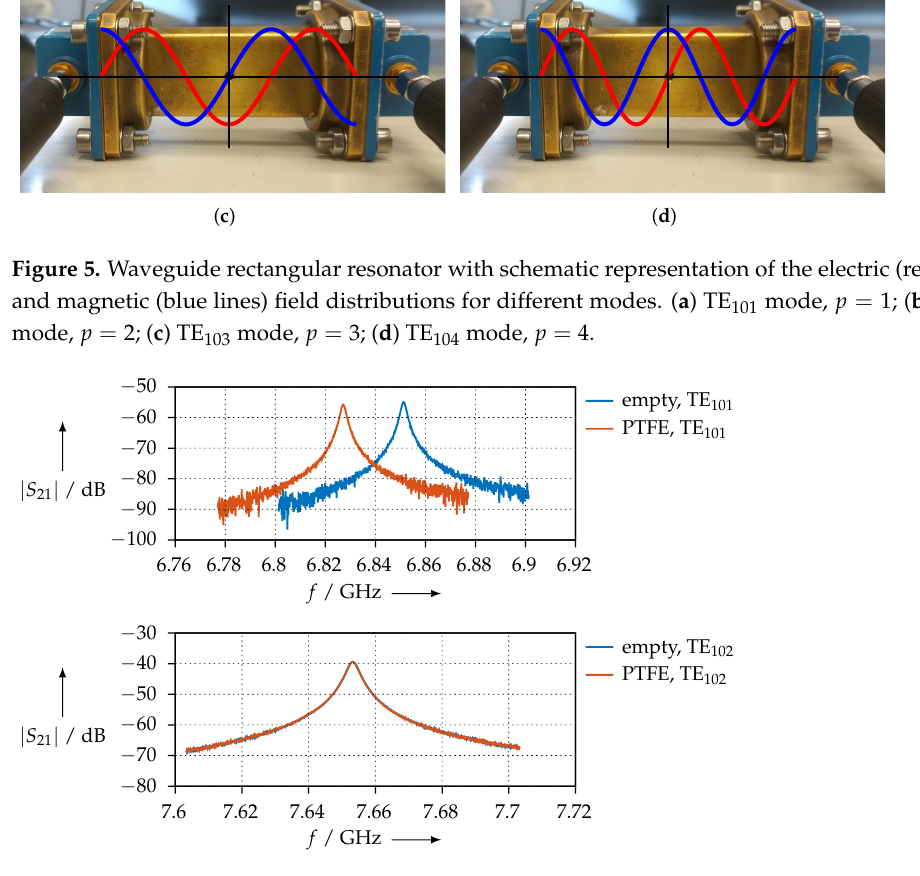
Figure 6. Example of the frequency response of the rectangular waveguide resonator with and without PTFE material sample for TE 101 ( upper chart) and TE 102 ( lower chart)